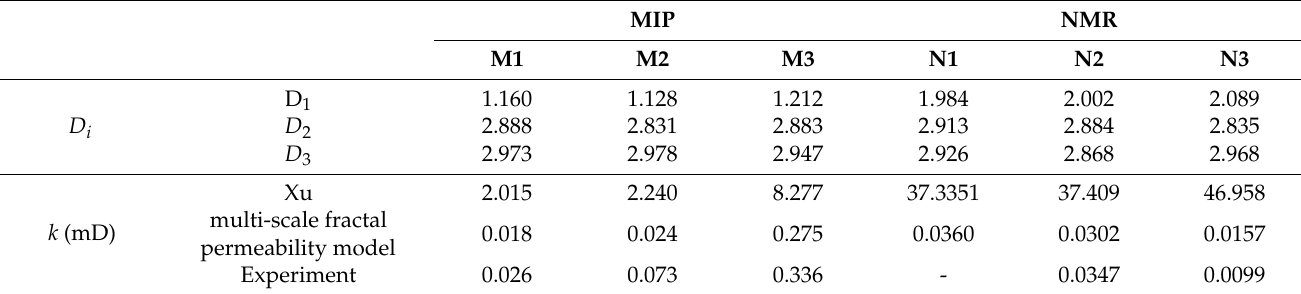
Table 3. Comparison between the MFU results and experimental